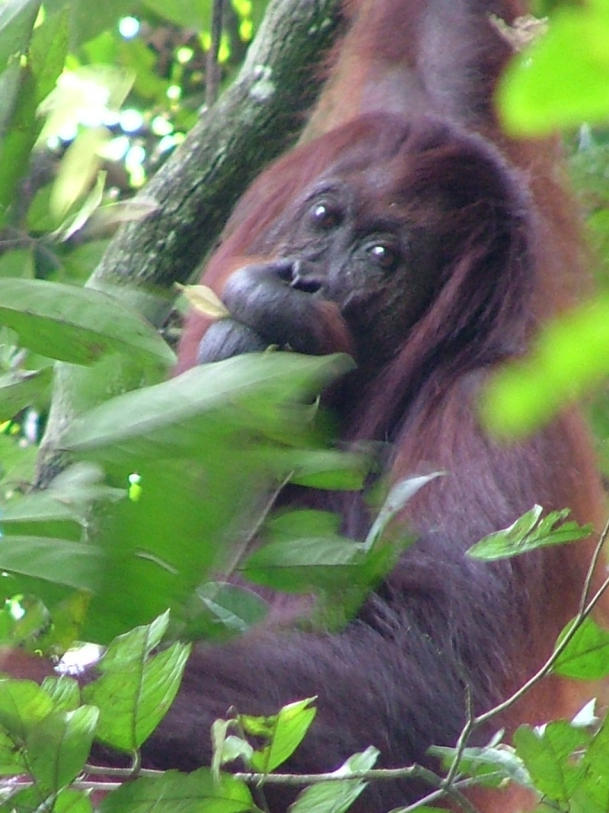
Ongoing deforestation and palm oil plantations leave no room for the orang-utan